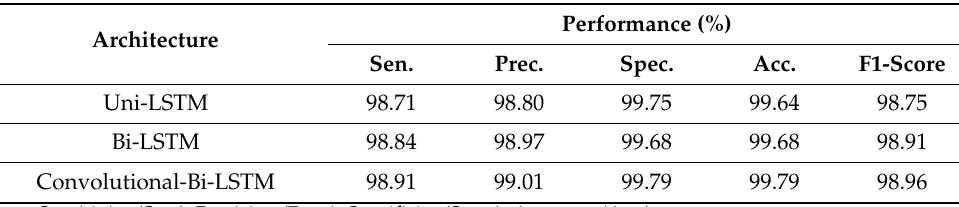
Table 5. The three LSTM architectures with the best result. Performance (%) Architecture Sen. Prec. Spec. Acc.